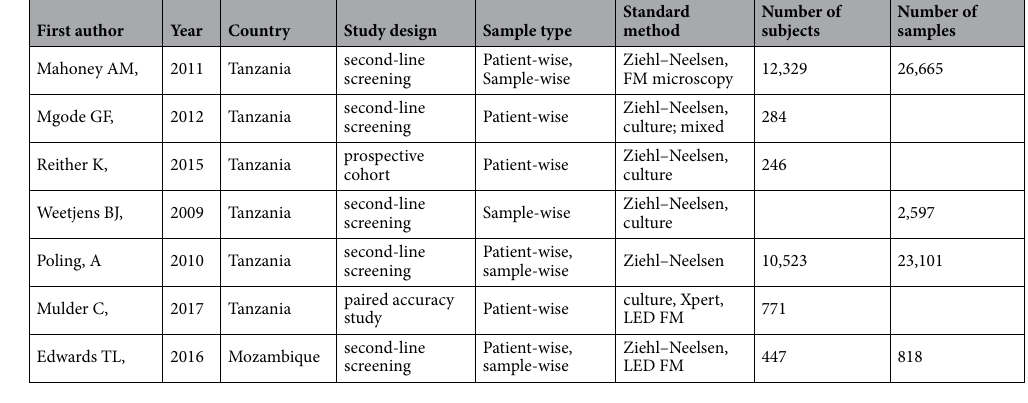
Table 1. Samples, subjects, and methods used for comparison with the rat-sniffing method. LED FM, Light- emitting diode fluorescence microscopy; Xpert, MTB/RIF test that detects Mycobacterium tuberculosis complex (MTBC) and resistance to rifampicin (RIF) on the GeneXpert multi-disease